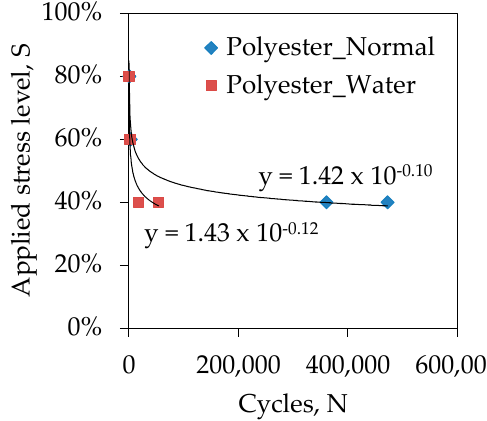
Figure 6. Comparison between different environmental conditions.